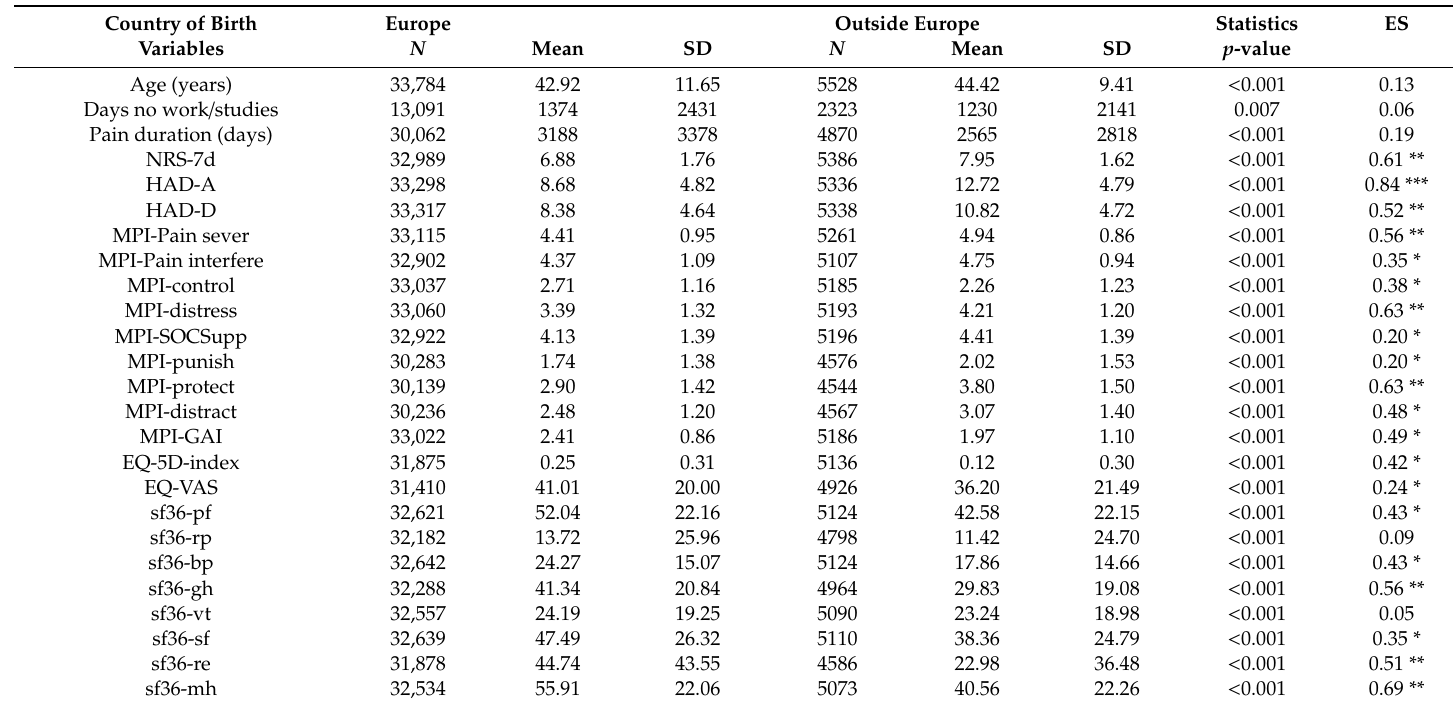
Table 5. Comparison at baseline between those born in Europe and those born outside Europe. The statistics ( t -test) and e ff ect size (ES; Hedges’g) are to the far right. Country of Birth